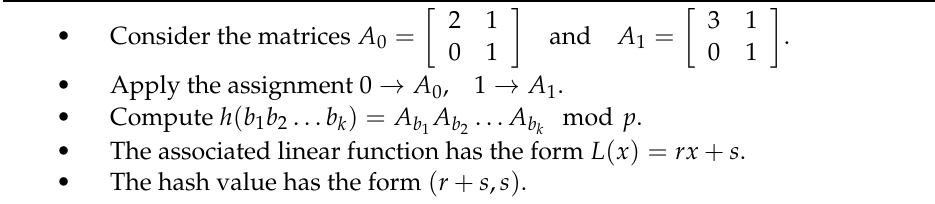
Algorithm 3: Sosnovski hash